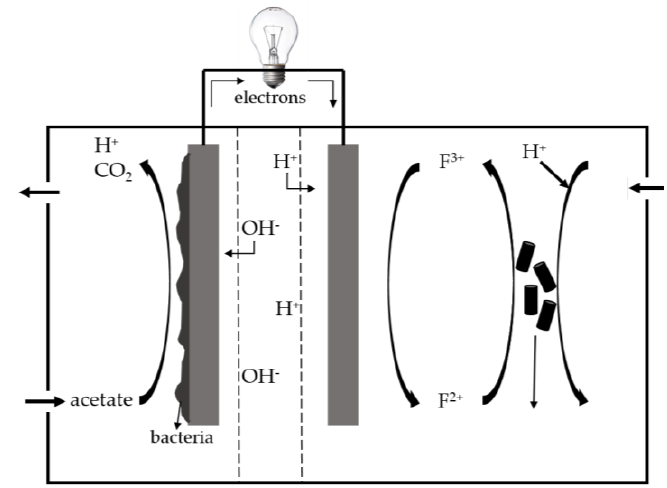
Figure 4. Design for the microbial fuel cell (MFC) with iron mediated cathode and bipolar membrane.